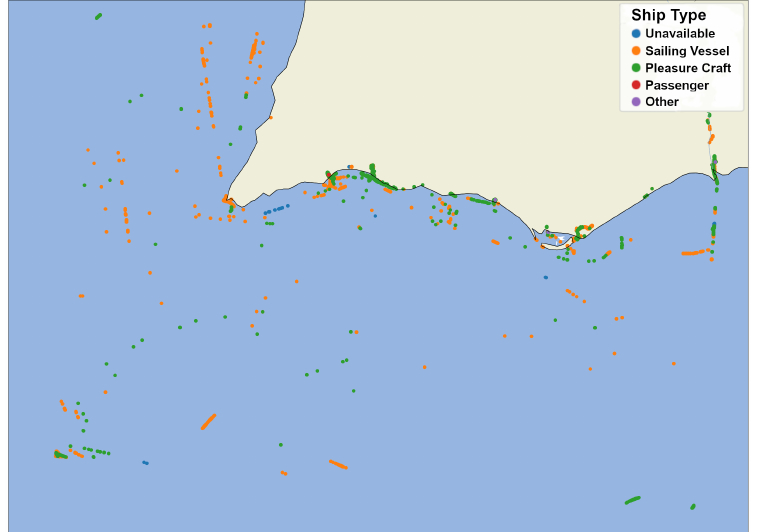
Figure 6. Registered reported locations of vessels in trips lasting under 10 min, coloured per vessel category (June